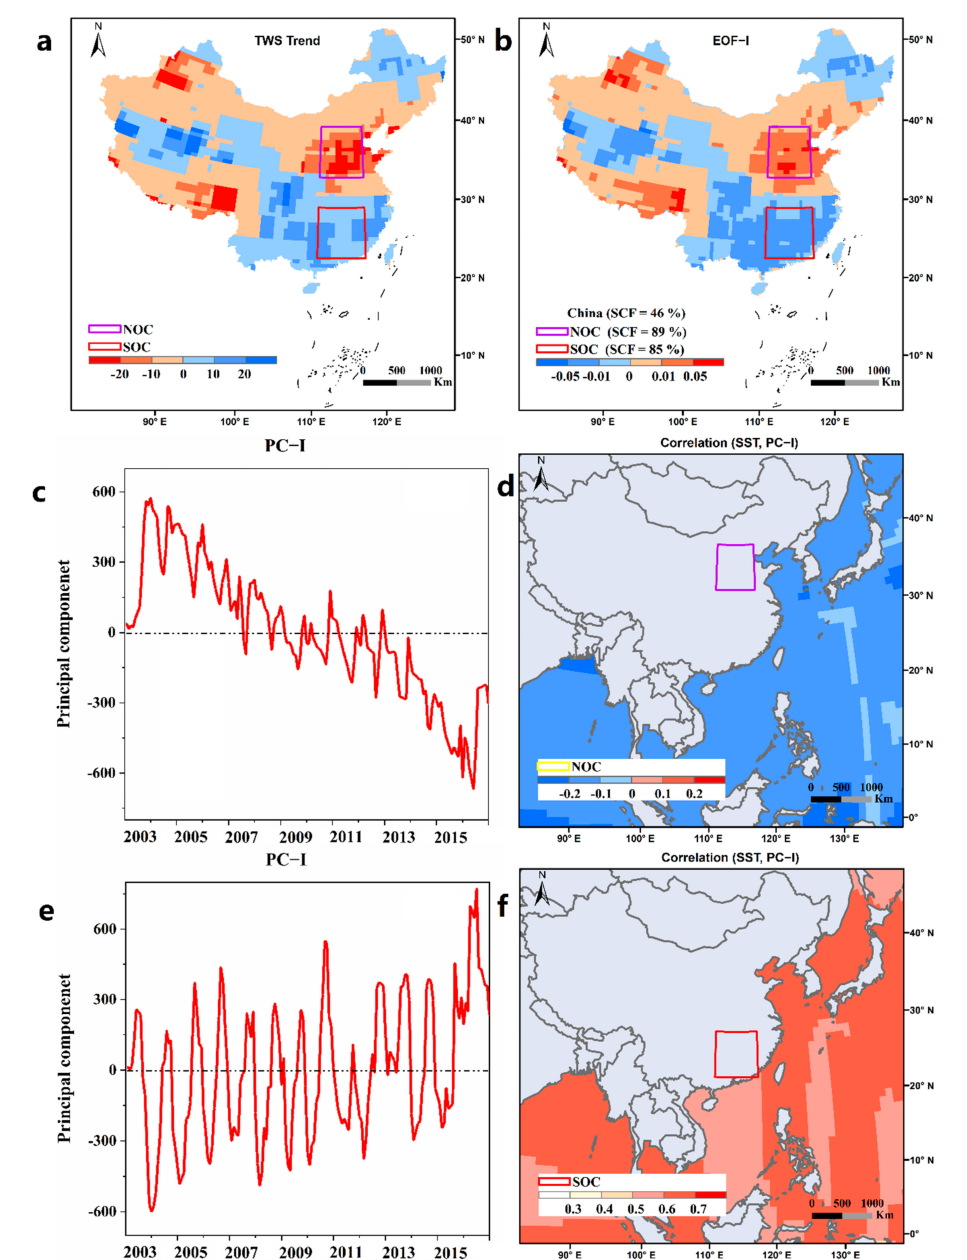
Figure 9. The linkage between terrestrial water storage and the sea surface temperature during 2003–2016 in the monsoon region. ( a ) The spatial trend of the linear regression models in total water storage was derived from the GRACE satellite. ( b ) The dominant mode (EOF-1) of variability was calculated by applying the empirical orthogonal function analysis of the total water storage from the GRACE satellite. North China and South China are represented by purple and red boxes in this map, respectively. The principal component (PC, PC-1) correspond to the EOF-1 ( c ) on NC and ( e ) on SC, respectively. The correlation between the sea surface temperature from the Pacific Ocean and PC-1 ( d ) on NC and ( f ) on